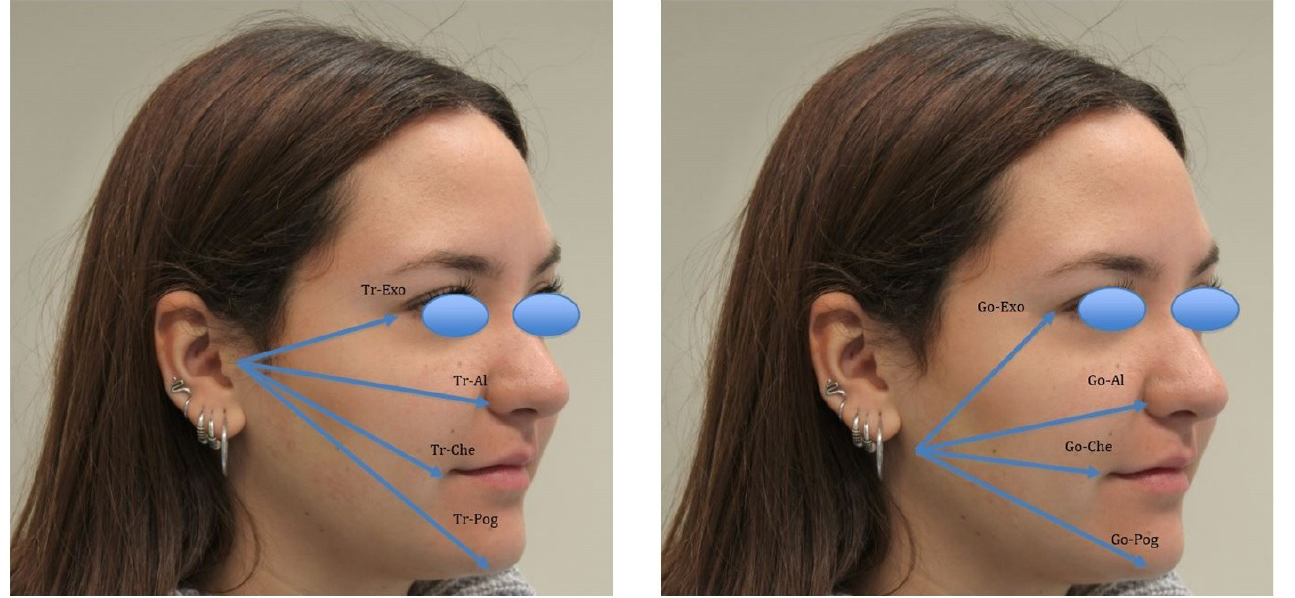
Figure 3. Facial and gnathological measurements for edema evaluation.